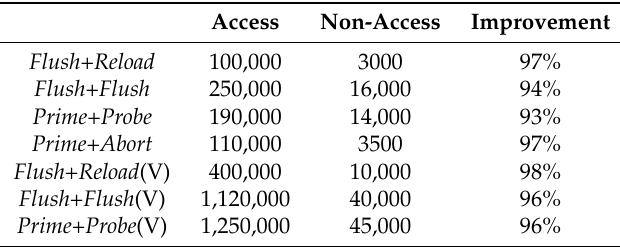
Table 4. Mean number of samples required to retrieve the whole 128 bits key with the access approach (first column), our approach (second column) and the improvement our approach means. (V) means virtualized